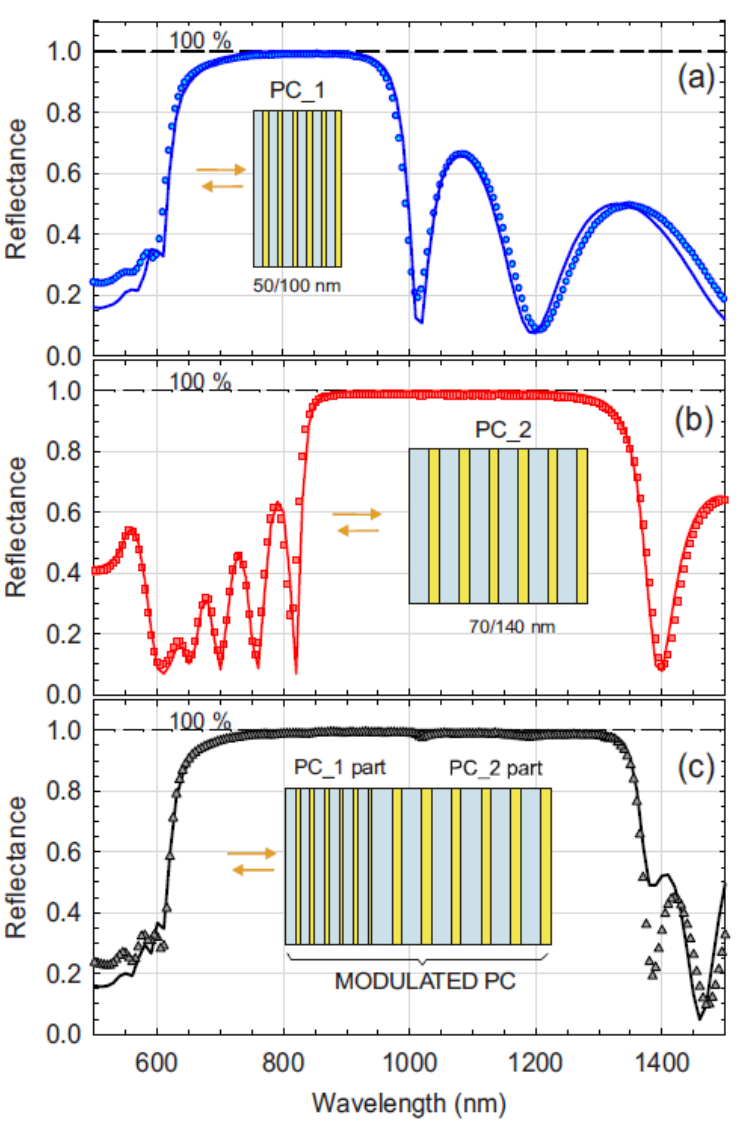
Figure 2. Reflectance of PC structures (symbols-measured, lines-simulated) based on a-Si:H and a-SiNx:H layers deposited on a glass substrate. (a) PC_1, (b) PC_2, and (c) modulated PC made of PC_1 and PC_2. The schematics of the PC structures, / d , are given in the insets (reprinted with permission thicknesses of the layers d a-Si:H a-SiNx:H from [18]. ©2009, American Institute of